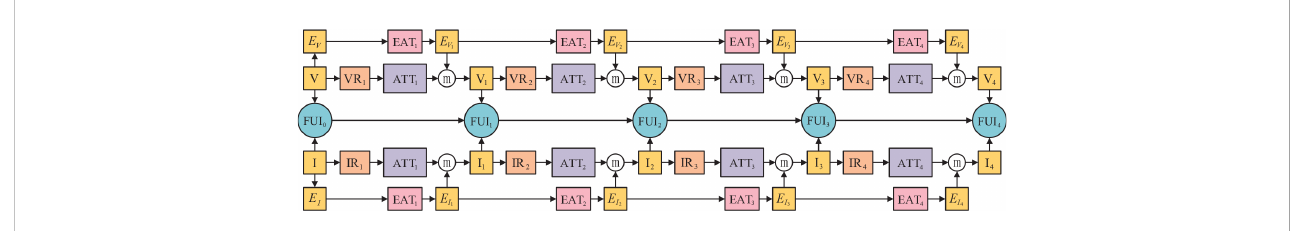
FIGURE 4 The overall structure for infrared and visible image